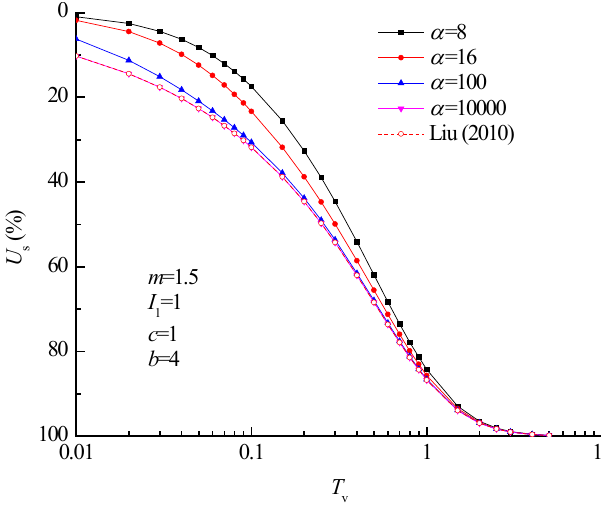
Figure 4. Influence of the interface parameter on ACDS [23].